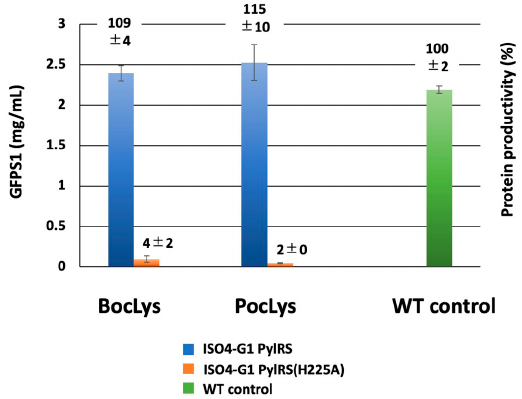
Figure 7. Cell-free protein synthesis with non-canonical amino acids using ISO4-G1 PylRS with the H225A mutation. The N11-GFPS1 proteins synthesized with the S30 extracts from E. coli B- 60 Δ A::Z/pMINOR cells in the presence of non-canonical amino acids. Non-canonical amino acids were site-specifically incorporated into the N11-GFPS1 protein at position 17 in response to the UAG codon, by using the ISO4-G1 PylRS·tRNA Pyl and ISO4-G1 PylRS (H225A)·tRNA Pyl pairs for BocLys and PocLys. The yields of the N11-GFPS1 proteins containing non-canonical amino acids were estimated by fluorescence. Protein productivities with non-canonical amino acids were compared with those of the cell-free synthesis of wild-type N11-GFPS1 protein containing Ala at position 17 (WT control) and are shown on the bars. The values represent the means of three independent experiments with standard deviations.